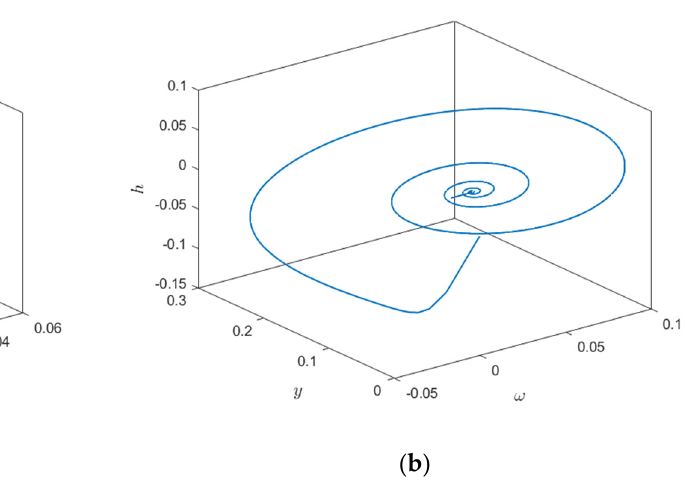
Figure 7. Phase space trajectories of x , y , ω for S 1 , S 2 , S 3 and S 4 . ( a ) S 1 ; ( b ) S 2 ; ( c ) S 3 ; ( d ) S 4 .